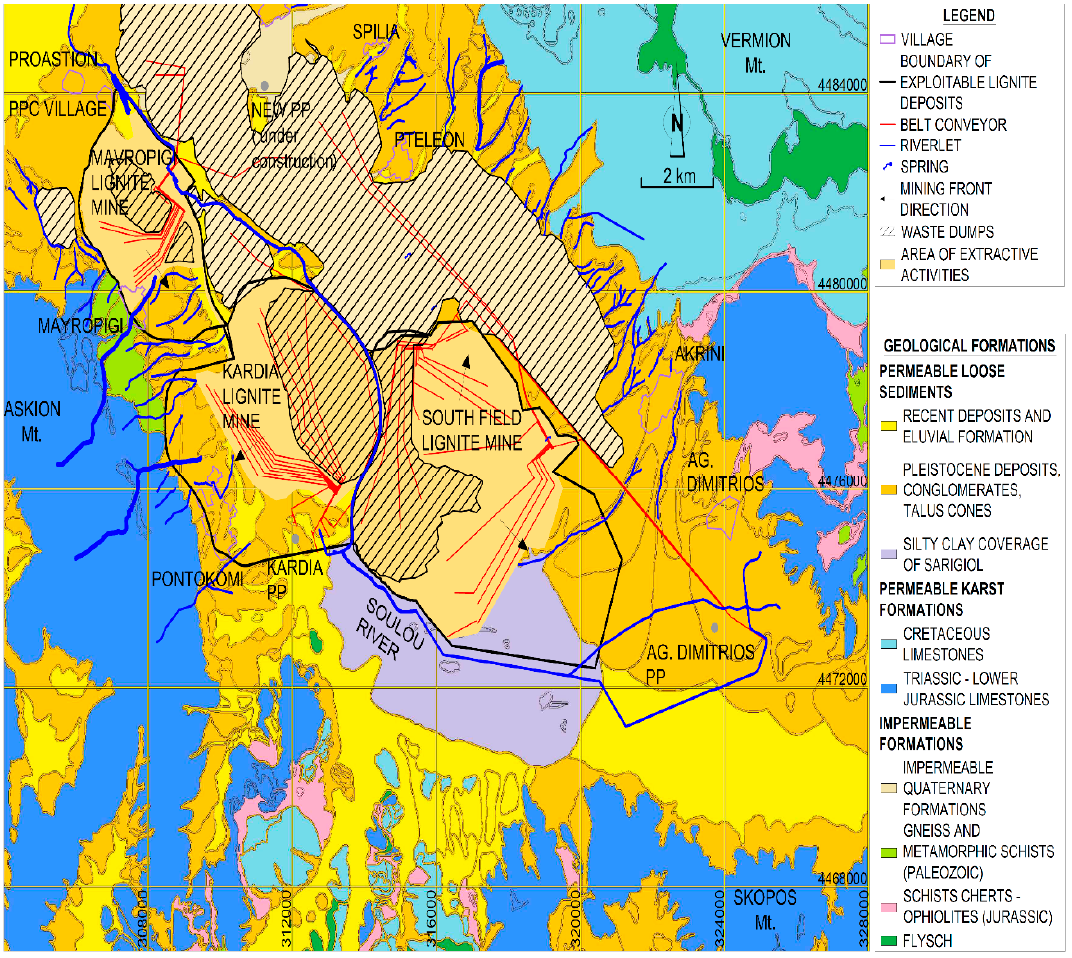
Figure 2. Geological map of the western Macedonia Lignite Centre (Ptolemaida mines) [13].